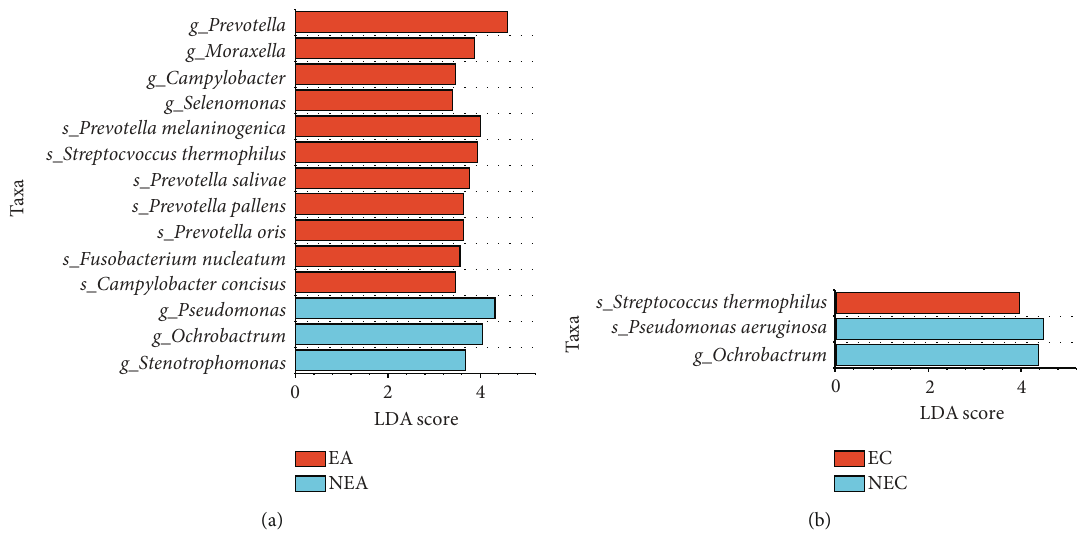
Figure 5: Di ff erential taxa of bacteria between eosinophilic and noneosinophilic in fl ammatory phenotypes. At genus and species levels, the LEfSe analysis between (a) EA vs. NEA and (b) EC vs. NEC. The LDA threshold was set at 3.0, and taxa with relative abundance less than 0.5% were fi ltered out.